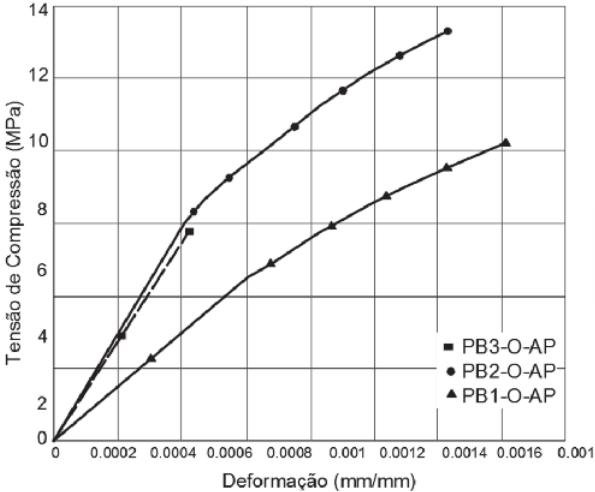
Curvas de tensão x deformação para as paredes PB-O-AP, considerando as três resistências